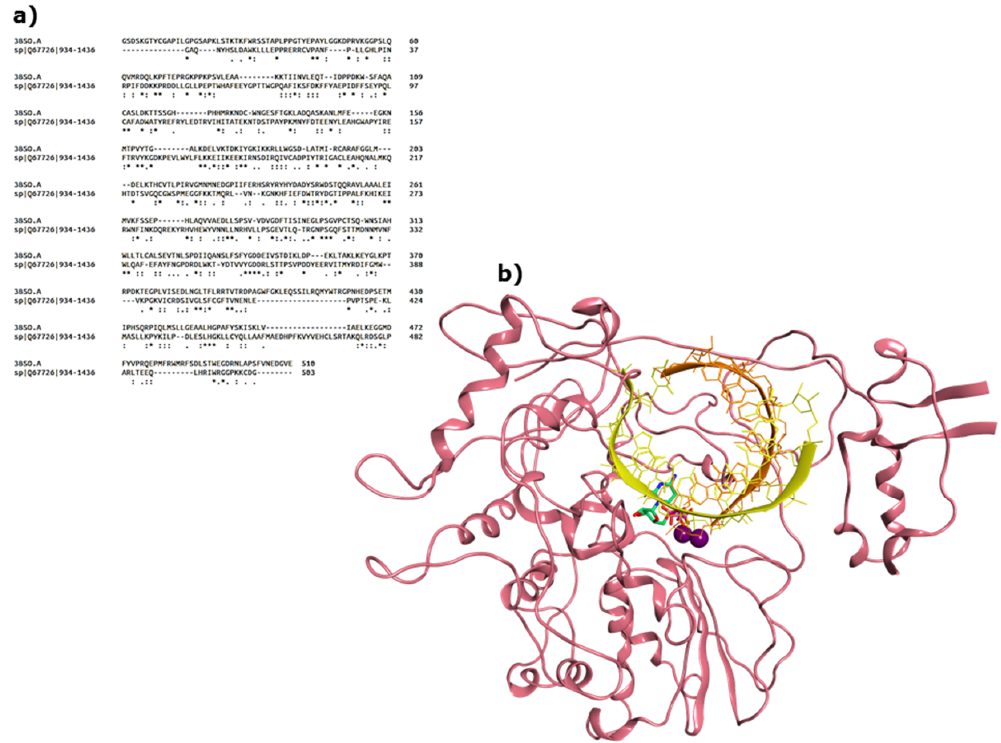
Figure 3. ( a ) Sequence alignment between HNoV RdRp from the 3BSO crystal structure and HAstV RdRp portion in the Q67726 sequence; ( b ) final model for HAstV